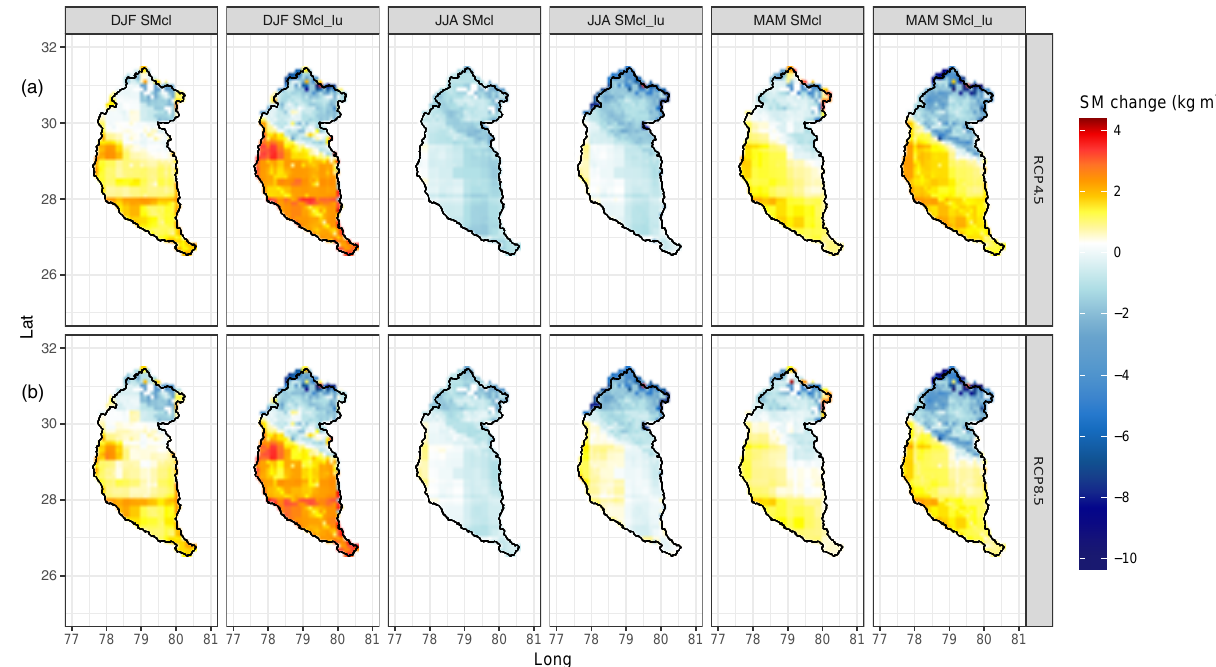
Figure 11. Absolute changes in spatial soil moisture (SM) fluxes between the historical simulation period 2000–2005 and the future projec- tion simulation period 2030–2035 for the Upper Ganges basin and for each of the emission scenarios (RCP4.5 and RCP8.5). Results are split into 3-month period seasonalities for winter (DJF), spring (MAM) and summer (JJA) under the two types of experiments: (a) only climate change is taken into account (SMcl) and (b) both climate change and land-use change are taken into account (SMcl_lu).